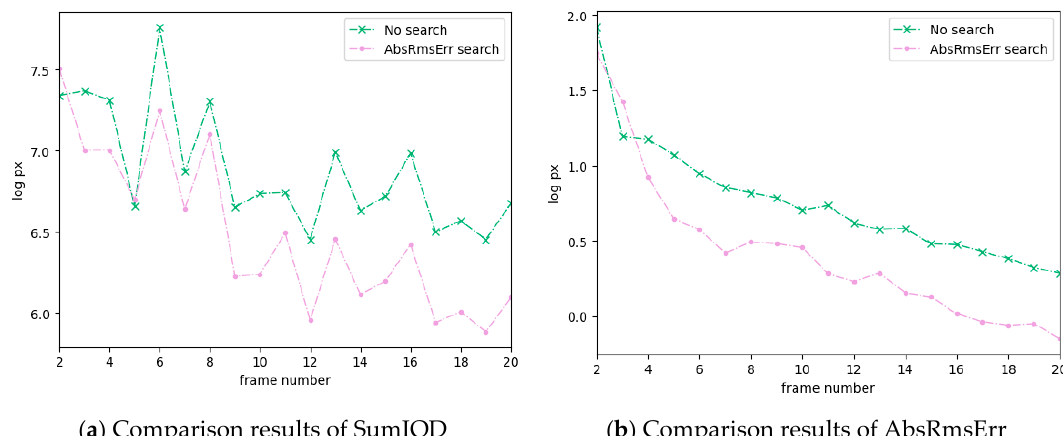
Figure 7. No search (Random pose) vs. absolute root mean square re-projection error (AbsRmsErr) search (Random pose + AbsRmsErr loss). The green dotted line is obtained by the calibration method with the random pose. The magenta dotted line is obtained by our proposed pose search algorithm.